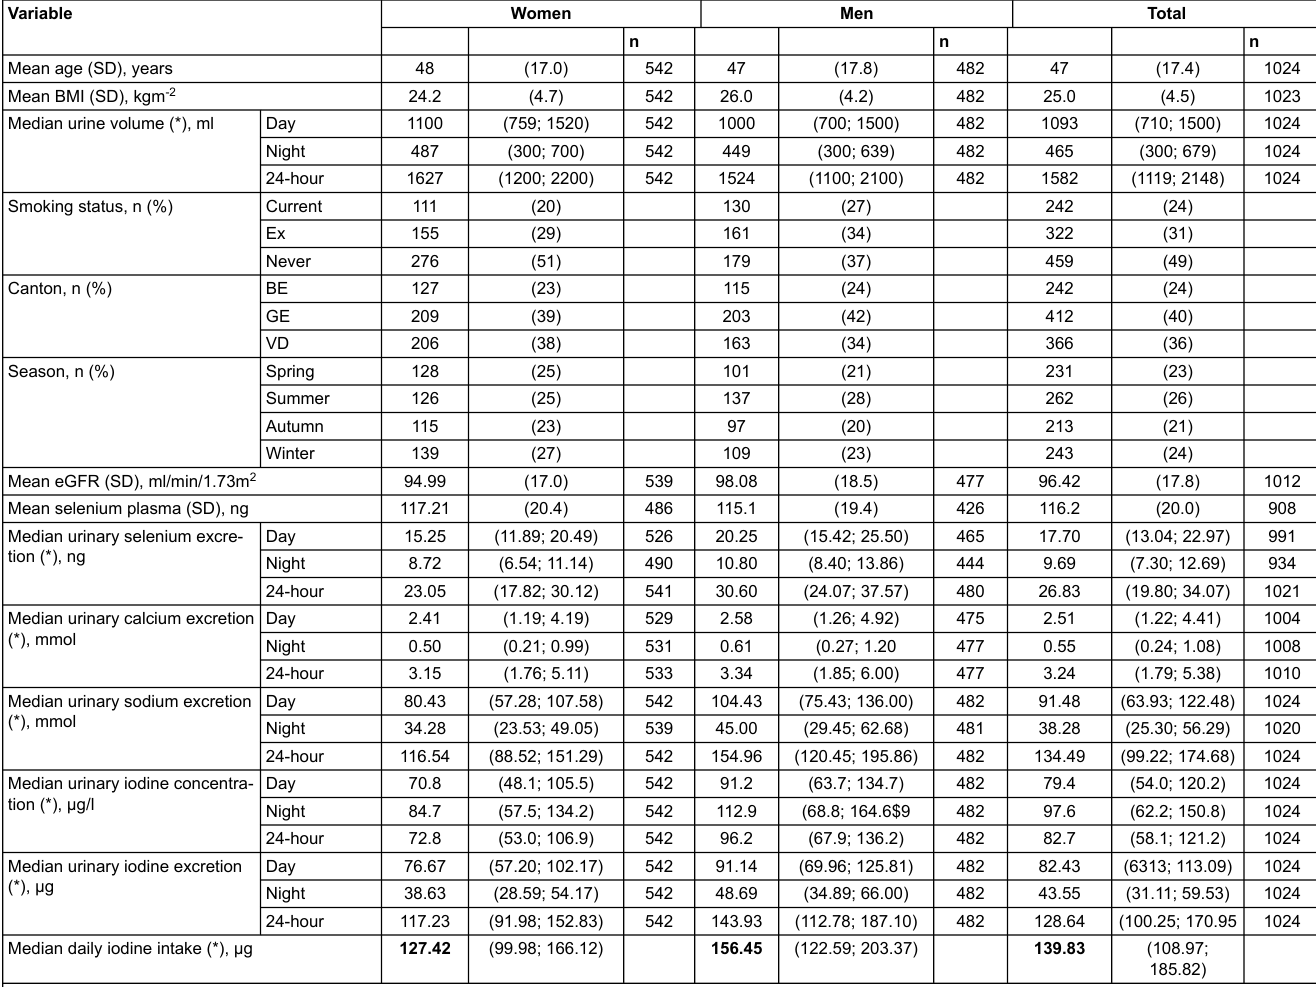
Table 1: Descriptive statistics of the sample population.